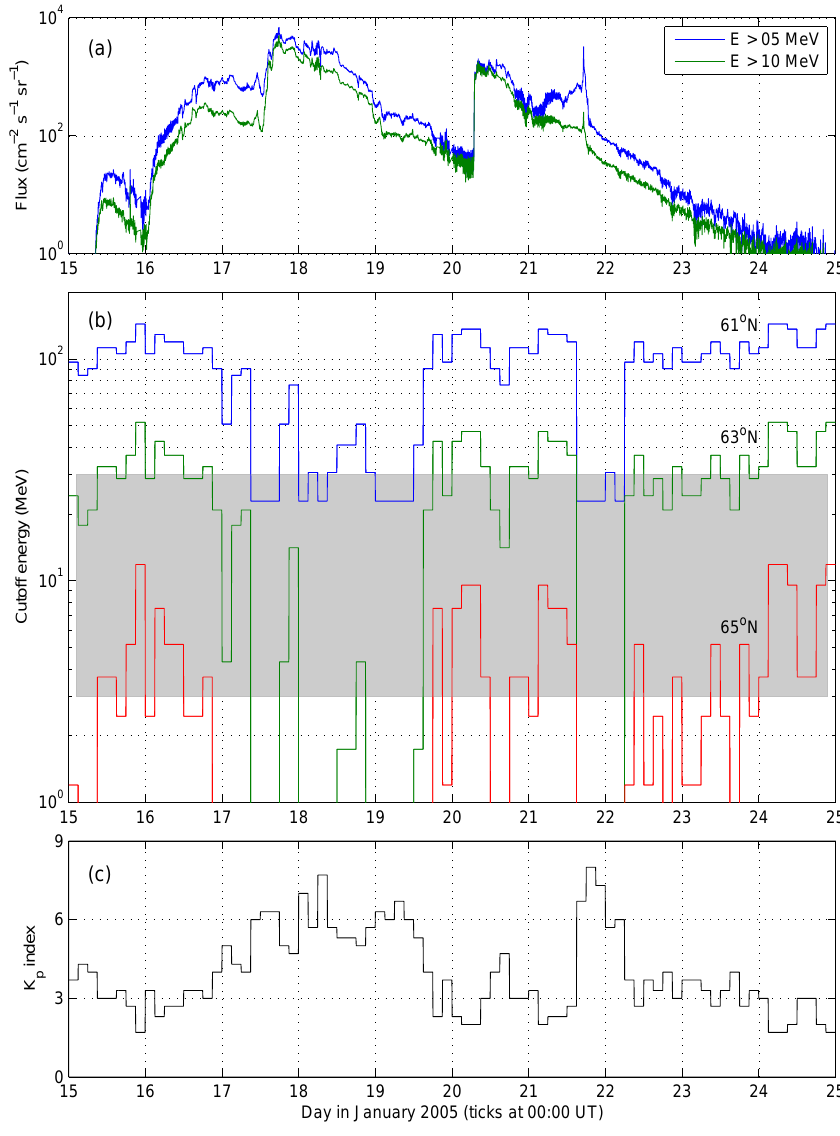
Fig. 1. (a) Proton fluxes measured at Geostationary Orbit by the GOES-11 satellite. (b) Estimated cutoff energies at selected magnetic latitudes. The grey area indicates the approximative energy range of protons depositing their energy in the mesosphere, i.e. 3–30MeV. (c) Planetary magnetic index K p